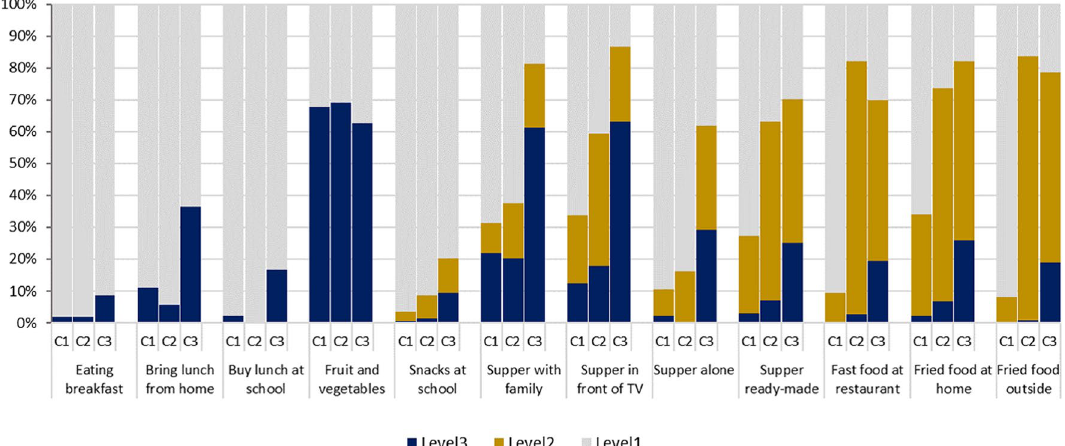
Figure 1. Within class item response percentages of the eating behaviours. C1-class 1 (healthy), C2-class 2 (less healthy), C3-class 3 (unhealthy). The item response level 1 to level 3 for the eating items were shown below. The items with three-categories: (a) Fast food at restaurant, Supper in front of TV, Supper alone, Supper ready-made: Level 3: ≥ 3 times per week; Level 2: 1–2 times per week; Level 1: less than 1 time per month; (b) Supper with family: Level 3: ≤ 2 times per week; Level 2: 3–4 times per week; Level 1: ≥ 5 times per week; (c) Eating fried food at home, Eating fried food out: Level 3: 4–6 times or daily per week; Level 2: 1–3 times per week; Level 1: Less than 1 time per week; (d) Buying snacks at school: Level 3: ≥ 3 times per week; Level 2: 1–2 times per week Level 1: Never/ < Once per week. The items with two-categories: (a) Eating breakfast, Bring lunch from home: Level 3: No, Level 1: Yes; (b) Buying lunch at school: Level 3: Yes, Level 1: No; (c) Fruit and vegetable intake: Level 3: < 6 daily servings, Level 1: ≥ 6 daily